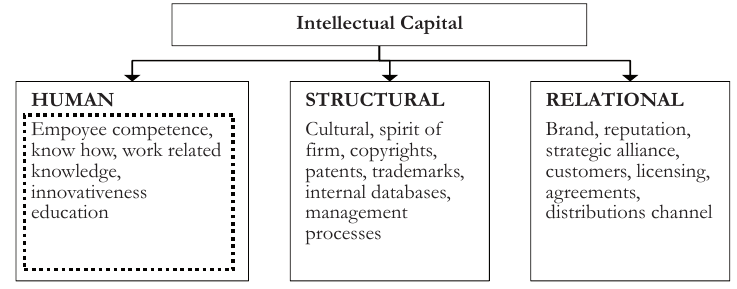
Fig. 1 – Content of Intellectual Capital and the Impact of Diversity Management on it. Source: Intellectual Capital Reporting,